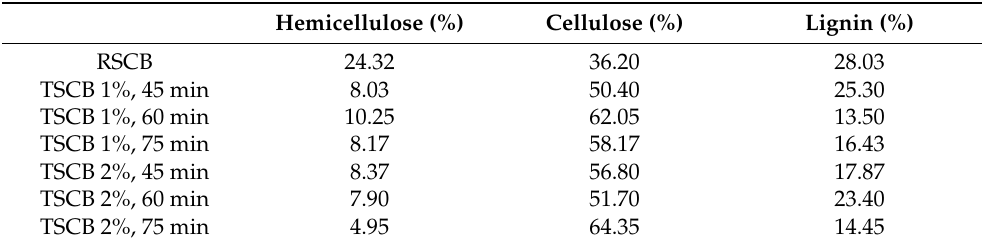
Table 1. Results of delignification process for raw sugarcane bagasse (RSCB) at a temperature of 100 ◦ C and stirring speed of 150